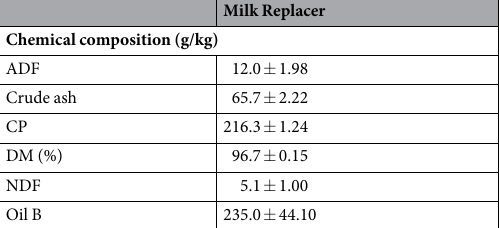
Table 1. Chemical composition of milk